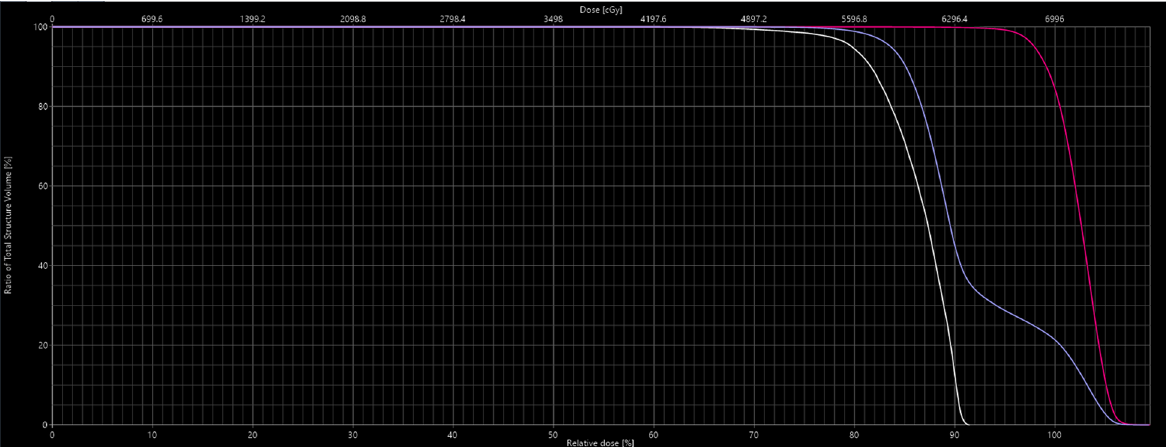
Fig. 2 DVH showing a graphical representation of PTV_HR volume (66Gy) (red), PTV_IR volume (60Gy) (purple), and metastatic skin nodule (white)